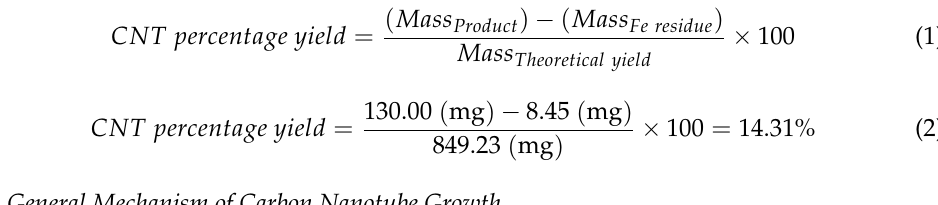
Table 2. Mass data and percentage yield results for CNTs grown using polystyrene.